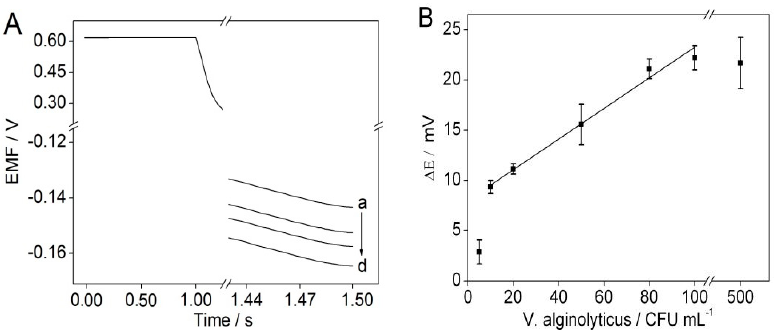
Figure 5. ( A ) Potentiometric responses of the solid-contact polycation-sensitive membrane electrode in 1.5 mL of 0.01 M sodium chloride solution with 5 μ g·mL − 1 protamine and 40 μ L DNA nanostructure-modified magnetic beads in the presence of ( a ) 100; ( b ) 50; ( c ) 10; and ( d ) 0 CFU mL − 1 V. alginolyticus . ( B ) Plot shows the potential changes over the V. alginolyticus concentration range of 5–500 CFU mL − 1 . Error bars represent one standard deviation for three measurements.